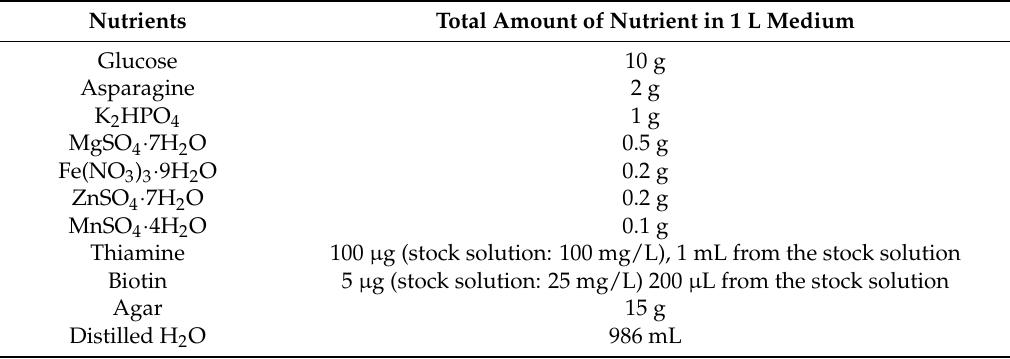
Table A3. Lilly & Barnett medium (LB, Lilly and Barnett, 1951).